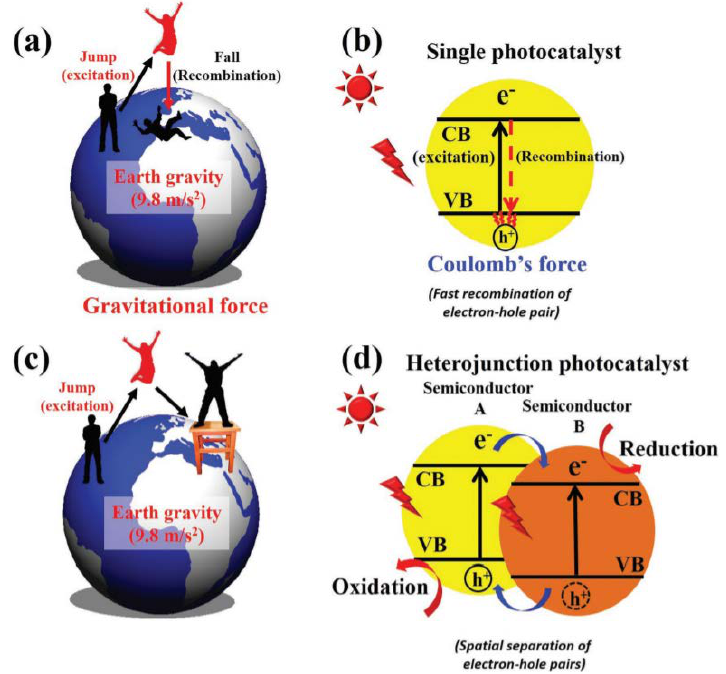
Figure 3. Illustration of: ( a ) the gravitational force effect on a jumping man; ( b ) electron–hole recombination on a single photocatalyst; ( c ) keeping a man off the ground using a stool; and ( d ) electron–hole separation on a heterojunction photocatalyst, adapted from [39].